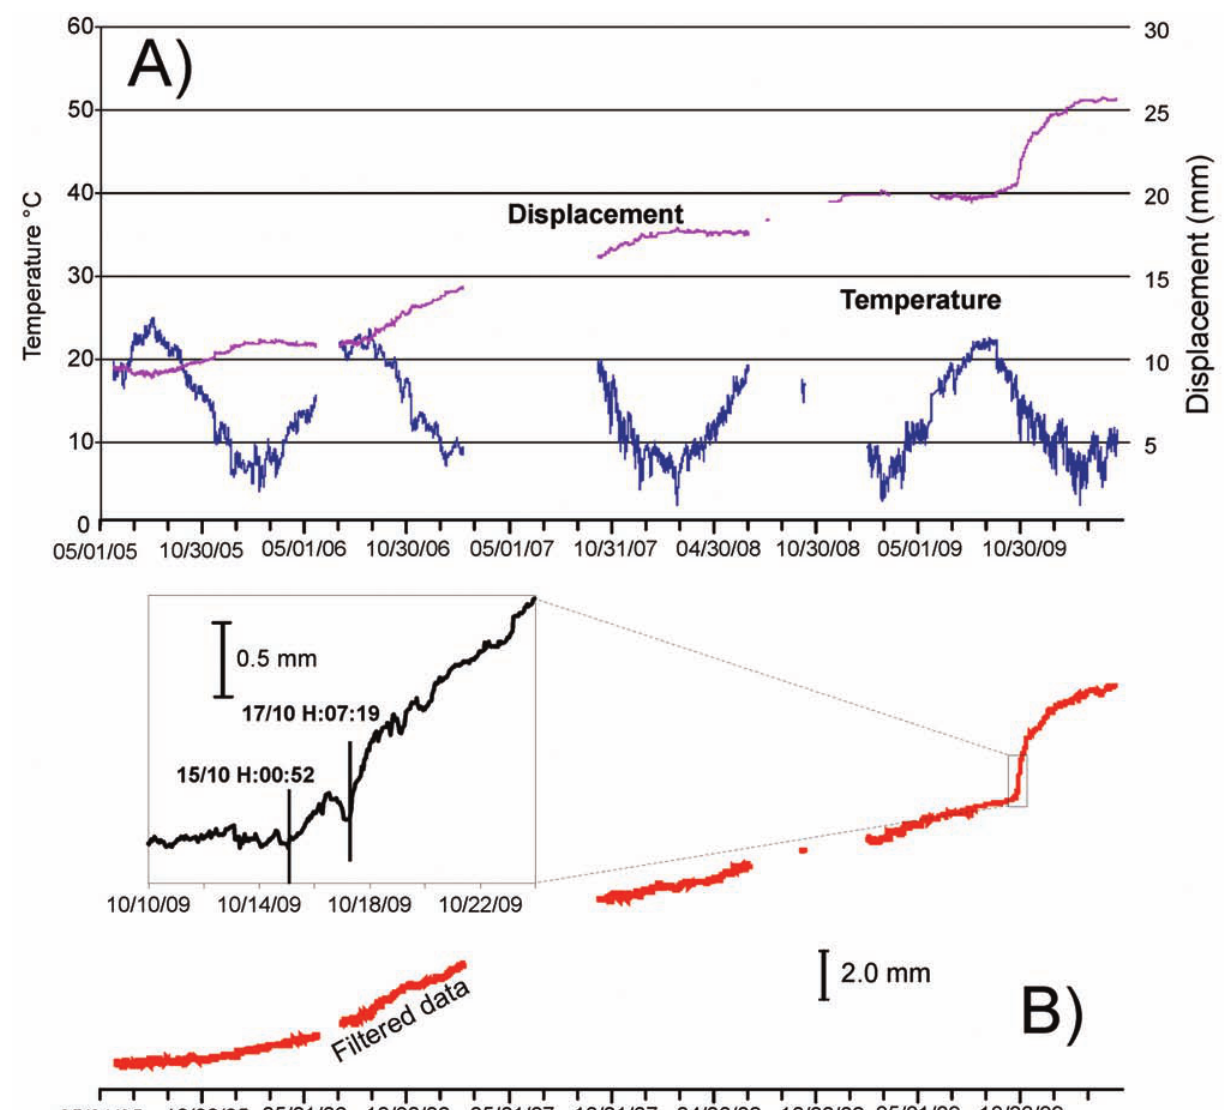
Figure 4. Distance trends and air temperatures (A) recorded at Et1 station, with the distance trends corrected for temperature effects (B), over the period from May 2005 to April 2010. Inset in (B): the time relationship between the displacements and the seismic events that occurred over the period of October 10-24, 2010. In coincidence with the beginning of the displacement anomaly, we recorded a M = 2.1 earthquake; two days later, a M = 1.8 earthquake occurred (17/10